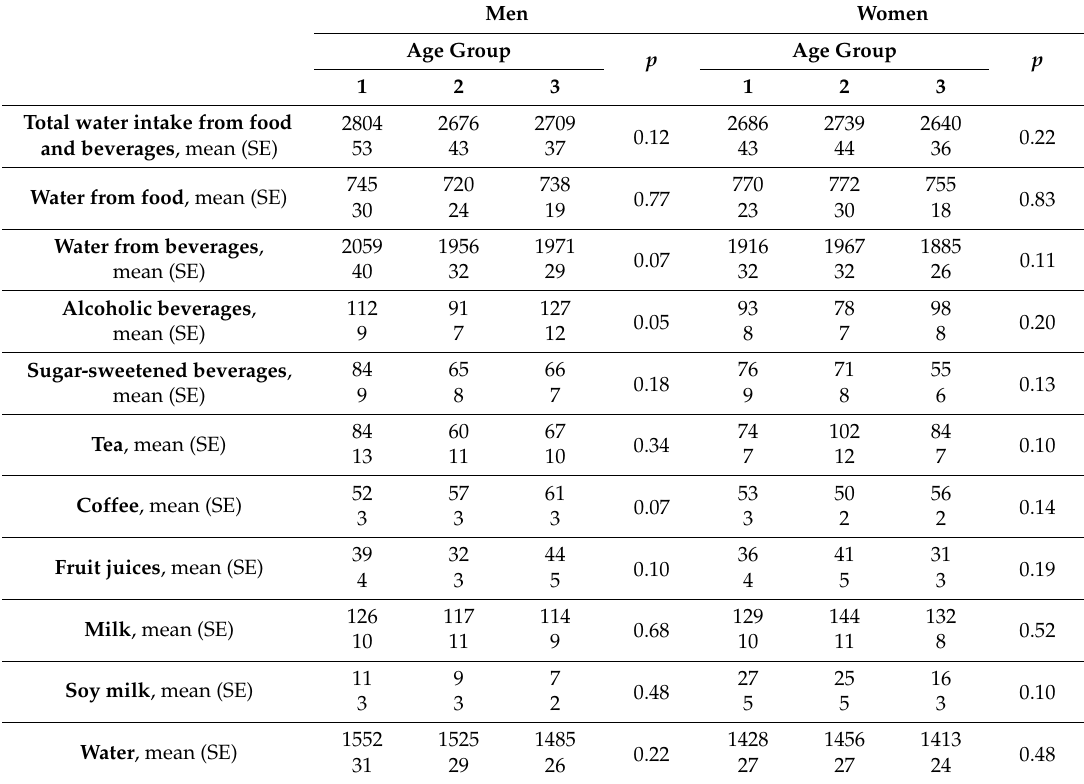
Table 4. Total water intake and beverage consumption (g/day) by age